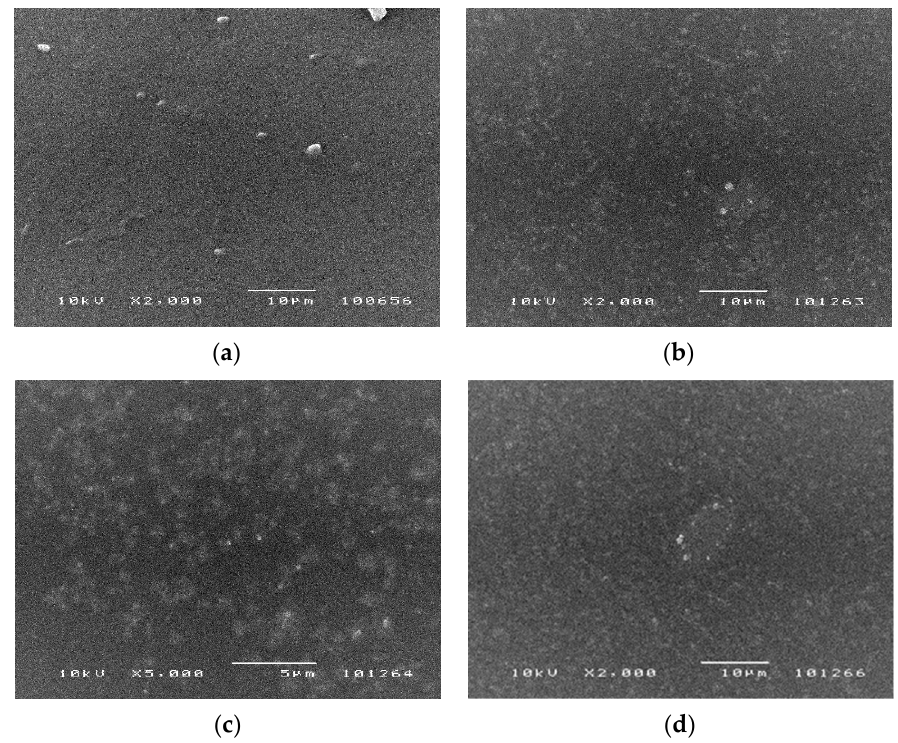
Figure 2. SEM pictures (×2000) of a typical sample of incisor replicas from the group of patients